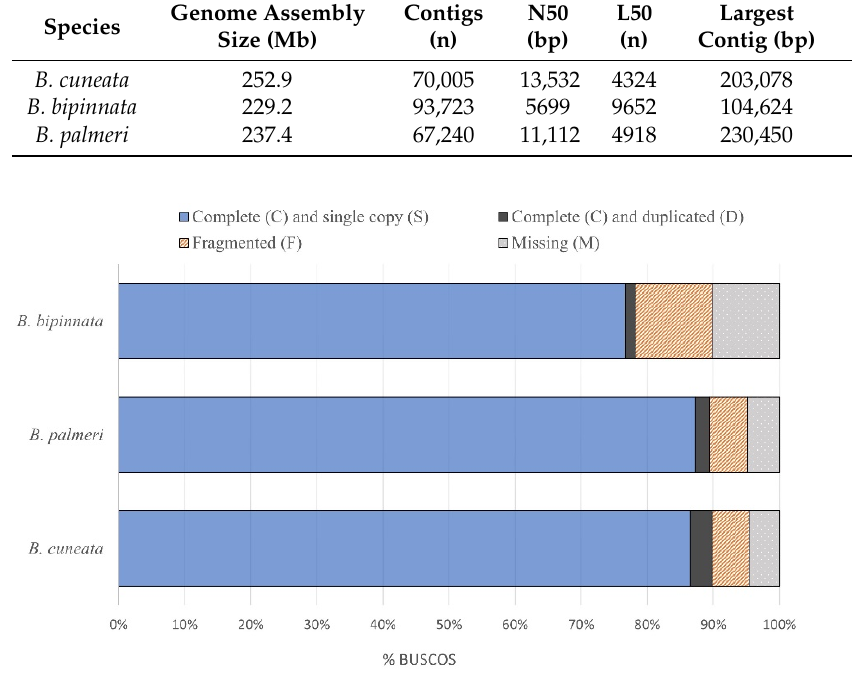
Figure 1. Results from three Bursera genome contiguity assessments using BUSCO.